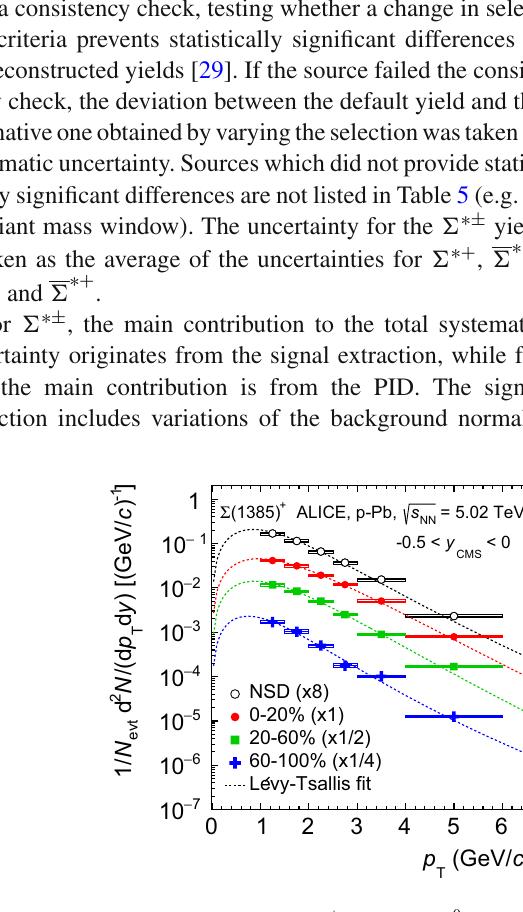
cal( bars )andsystematic( boxes )uncertaintiesareincluded.The dashed curves are Lévy–Tsallis fit to each individual